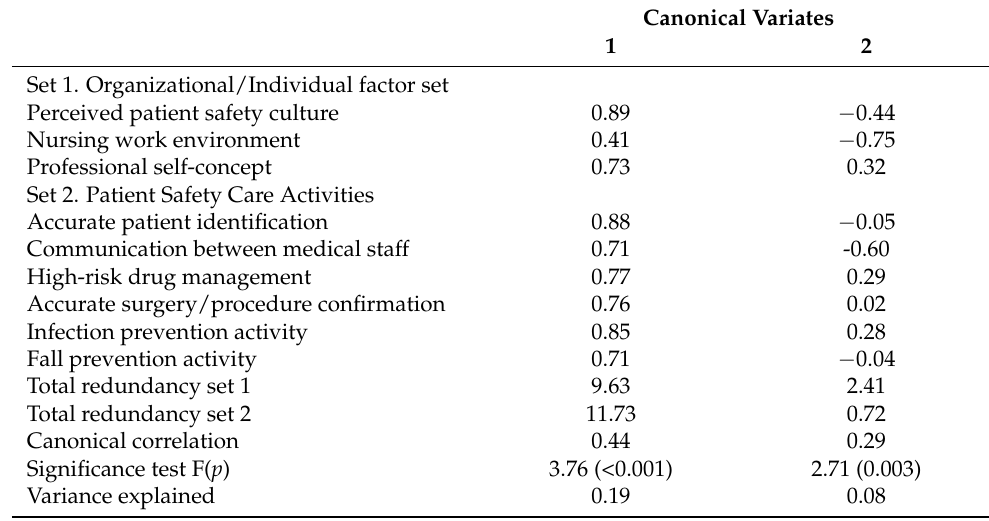
Table 3. Predictors of Patient Safety Care Activities of nurses working in small and medium-sized hospitals (N =